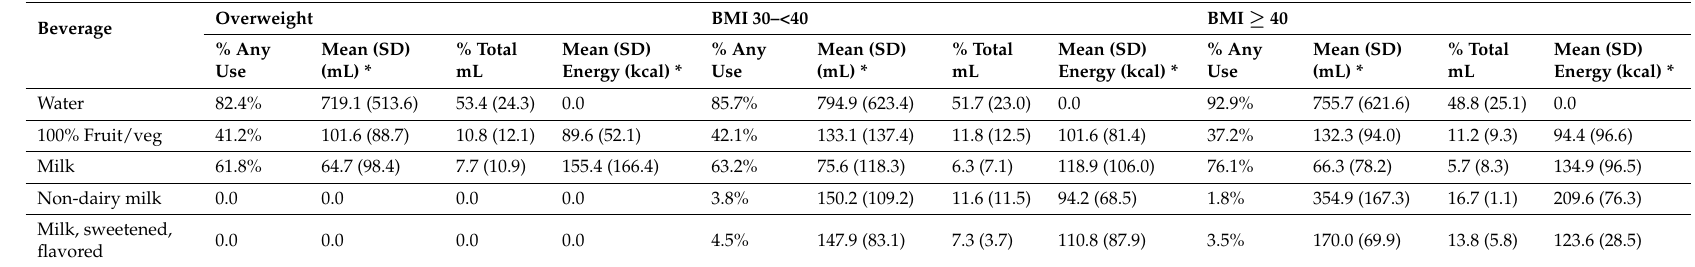
Table 2. Mean (SD) Beverage Volume (mL), Percent Total Beverage Volume (%) and Mean (SD) Energy Contribution (kcal) from Selected Subgroups of Beverages by